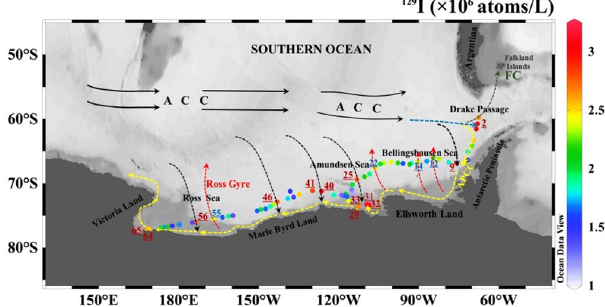
Figure 4. Distribution of 129 I (10 6 atoms/L) along the transect suggested surface sea current pathways (dashed arrows). Black dashed arrows for the southern branch of Antarctic Circumpolar Current (ACC); red dashed arrows for the northern branch of Antarctic Peninsula Coastal Current (APCC); yellow dashed arrows for APCC; green dashed arrows for Falkland Current (FC) 49, 50 ; black arrows for ACC. The original map